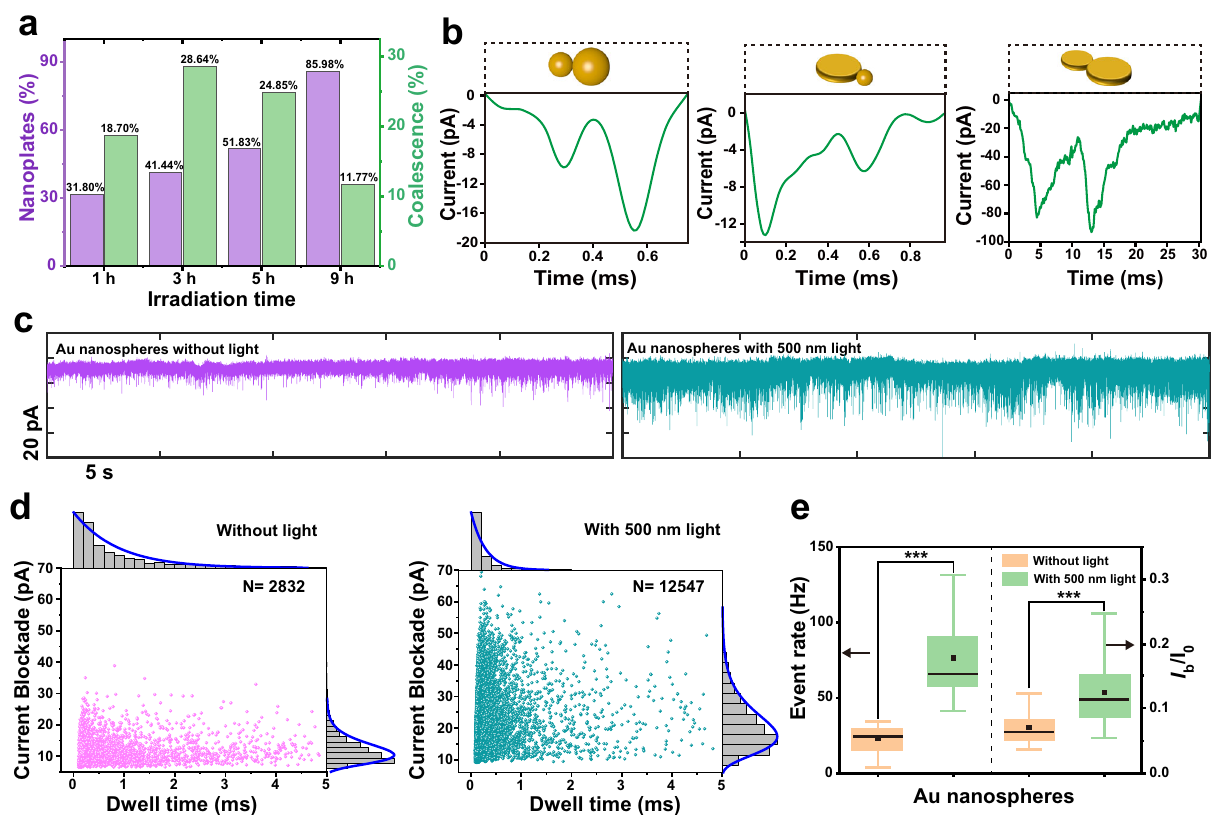
Fig. 3 Nanopore analysis of the morphological conversion mechanism of Au nanospheres to Au nanoplates. a The ratio of nanoplates and coalescence in the process of morphology transformation obtained from CNN prediction model and peak analysis code, respectively. 1135, 1035, 1283, and 1198 events were obtained in the 1, 3, 5, and 9 h samples, respectively. A representative current trace and event scatter plots of dwell time vs. current blockade of all the experiments are displayed in Supplementary Figs. 27 and 28. b Typical nanopore current – time peak shape for nanoparticle-nanoparticle, nanoparticle- nanoplate, and nanoplate-nanoplate coalescence events (left to right). c Current versus time trace of Au nanospheres without (left) and with 500 nm light (right). d Scatter plots for t d vs. I b of Au nanospheres translocation without (left) and with 500 nm light (right) from ( c ) and along the sides are the corresponding histograms. Measurements were collected using a same ~20 nm nanopore at a bias voltage of 1 V. The baseline current is about 310 pA and RMS is 2.18 pA. e Box plots of event rate and I b / I 0 from Au nanospheres with 500 nm light and without light. Box plots show median (black line), mean (black square box), quartiles (boxes), and range (whiskers). Mann – Whitney U tests, *** p <